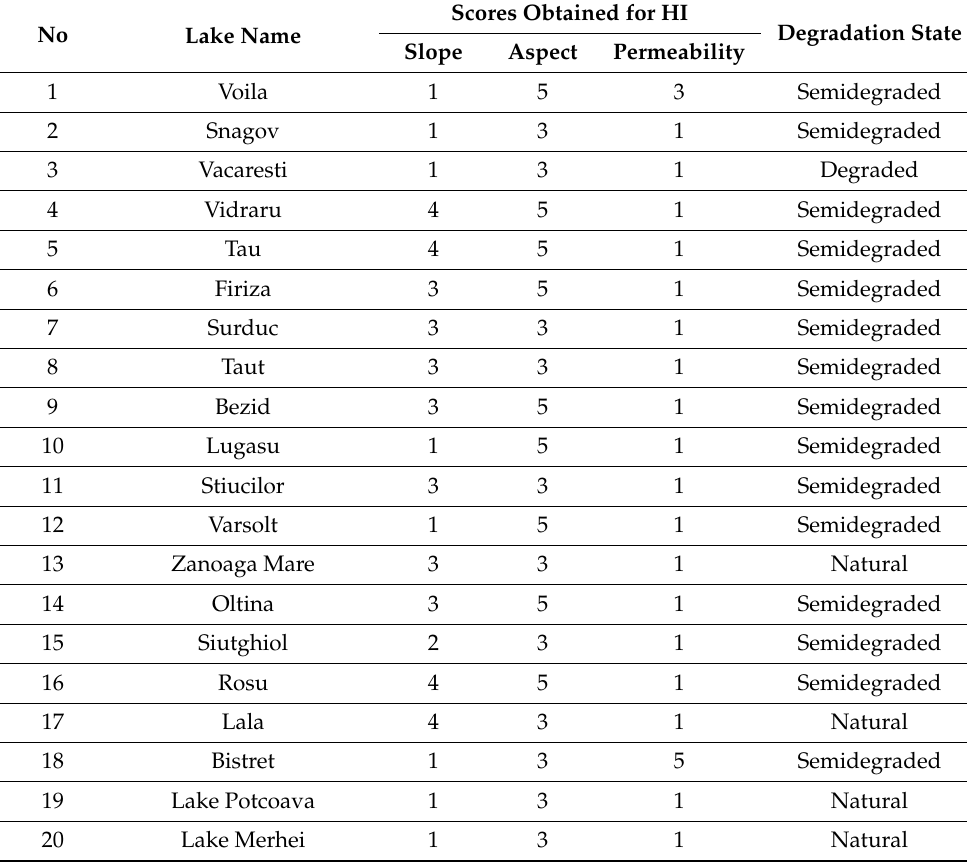
Table 8. Results of the evaluation for HI index and degradation